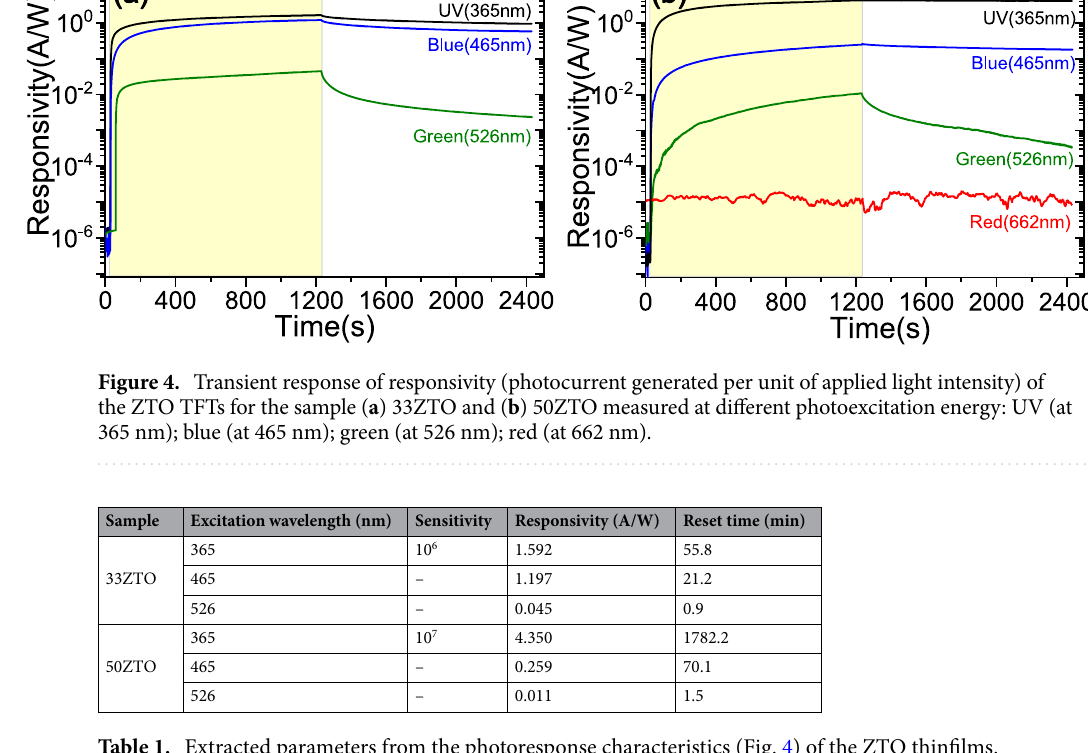
Table 1. Extracted parameters from the photoresponse characteristics (Fig. 4) of the ZTO thinfilms.